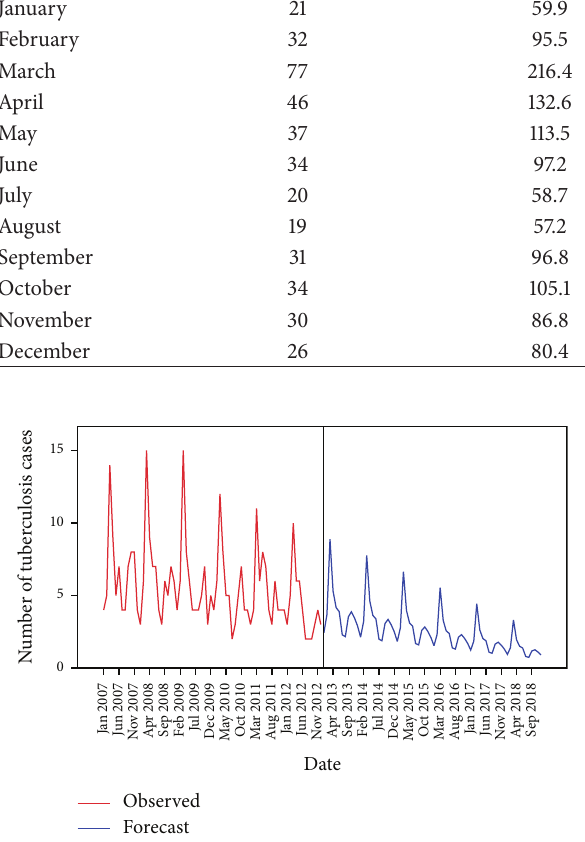
Figure 4: Sequence chart for forecasted tuberculosis cases in the near